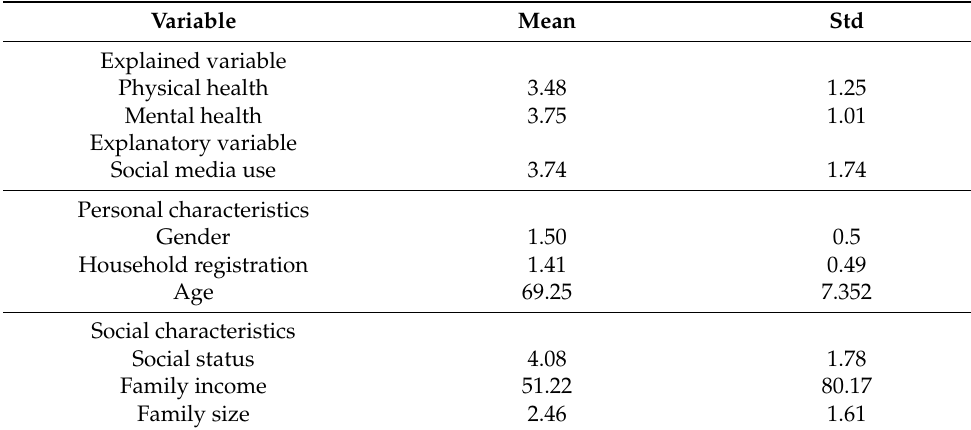
Table 1. Descriptive statistics of the main variables ( n = 1278).